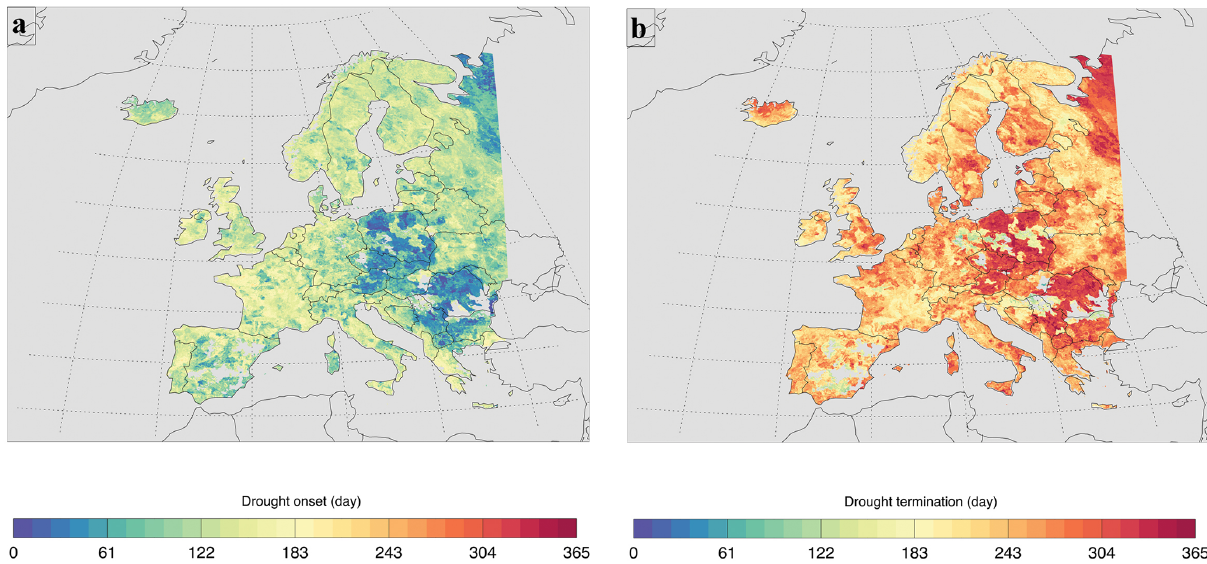
Figure 6. Spatial distribution of the average drought onset (a) and termination (b) of the longest drought per year (in drought years) derived from drought in groundwater over the period 1990–2017. Non-drought years are excluded.